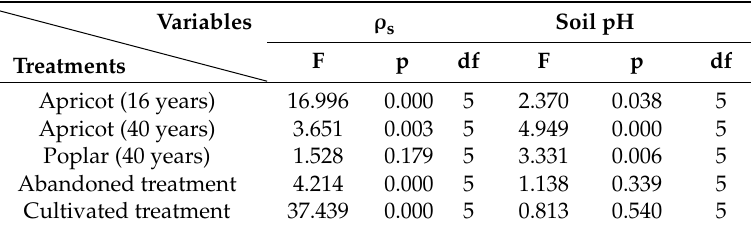
Table 4. Effects of soil depth on soil bulk density ( ρ s ) and pH in different treatments.